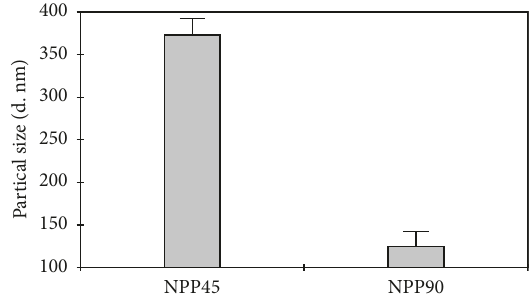
Figure 1: Means of particle size of nano-pomegranate peel powder (NPP45 and